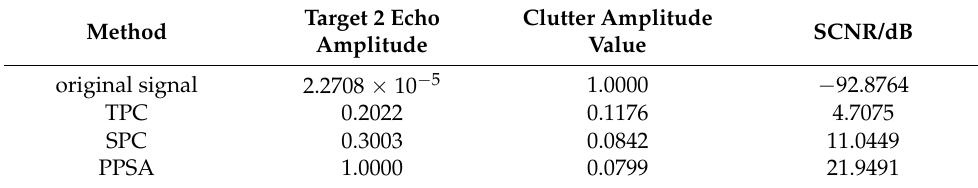
Table 10. SCNR comparison of target